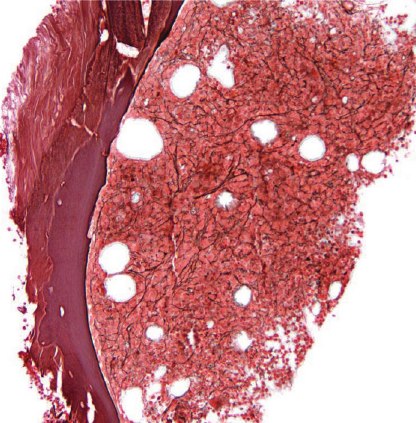
Figure 2: Bone marrow biopsy after treatment with romiplostim demonstrating marked di ff use reticulin fibrosis (Note coarse retic- ulin fiber network) (Silver stain, original magnification × 400).